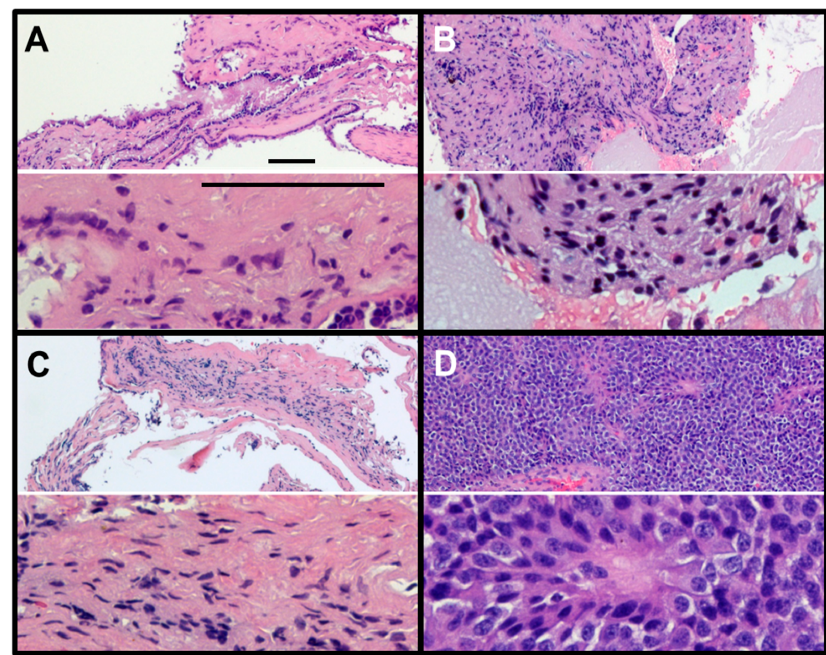
Figure 3 . Hematoxylin and eosin (H&E) staining of RCCs ( A – C ) and NF pituitary adenoma ( D ). RCCs show very little nuclear staining (hematoxylin, blue) but show very large regions of hydrophobic protein (eosin, red). In contrast, the NF pituitary adenoma shows close-packed small cells with only a few regions labelled with eosin (red), the typical features of a tumor (magnification: upper slide, 10×; lower slide, 40×; scale bar = 100 µ m). Cancers 2020 , 1 , x